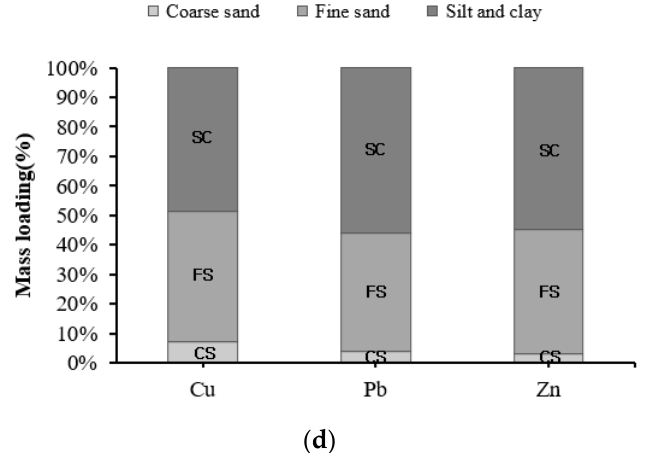
Figure 12. Heavy metal mass loading for the three particle-size fractions: ( a ) contaminated soil; ( b ) washed soil; ( c ) treated soil; and ( d ) separated soil. Table 3. Heavy metal concentration of contaminated soil for three particle size fractions. Particle Size (mm)